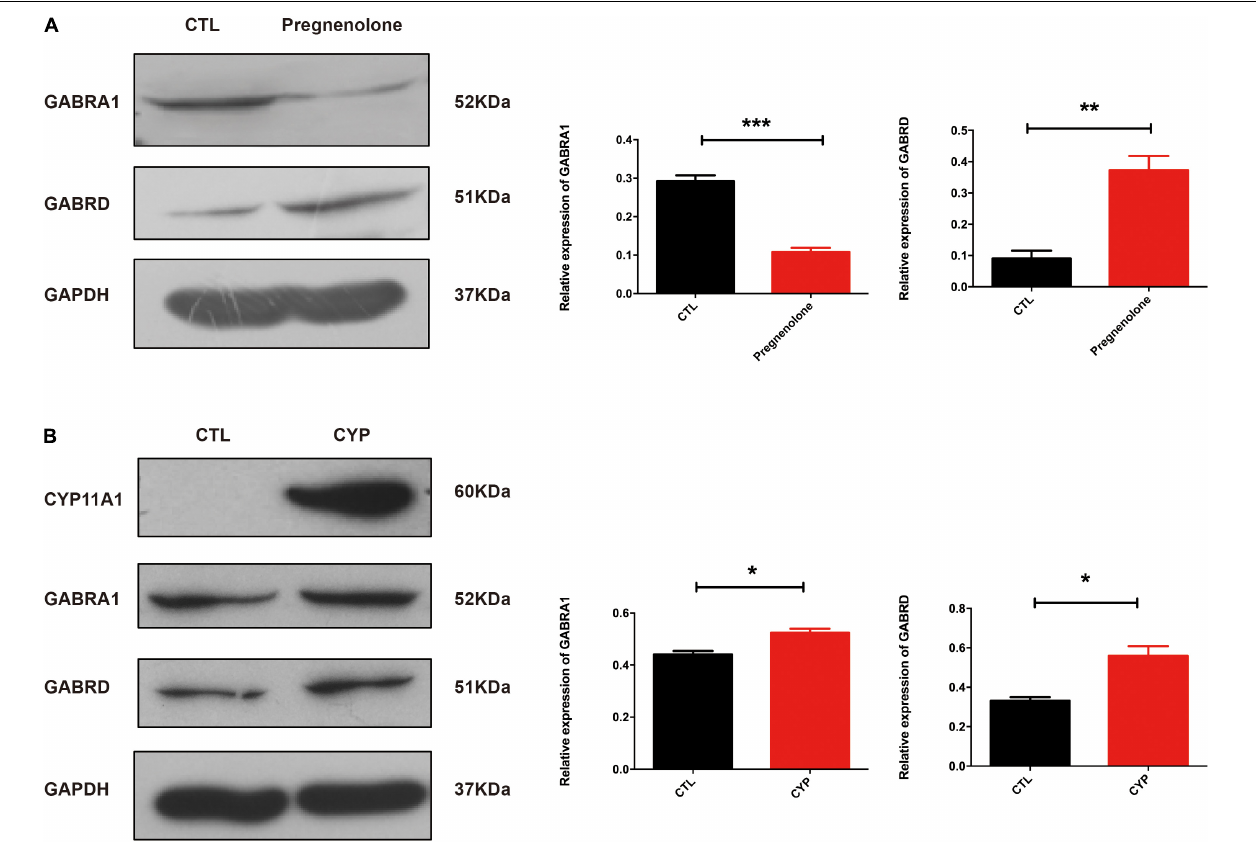
FIGURE 4 | CYP11A1 overexpression lead to altered GABAA receptor expression in primary microglial and neuronal cultures. (A) Western blot analysis showed that pregnenolone treatment decreased GABRA1 and increased GABRD expression in N2A neurons. (B) GABRA1 and GABRD expression was induced by CYP11A1 overexpression. GAPDH was used as an internal control (* P < 0.05, ** P < 0.01, and *** P < 0.001). The experiments were repeated two